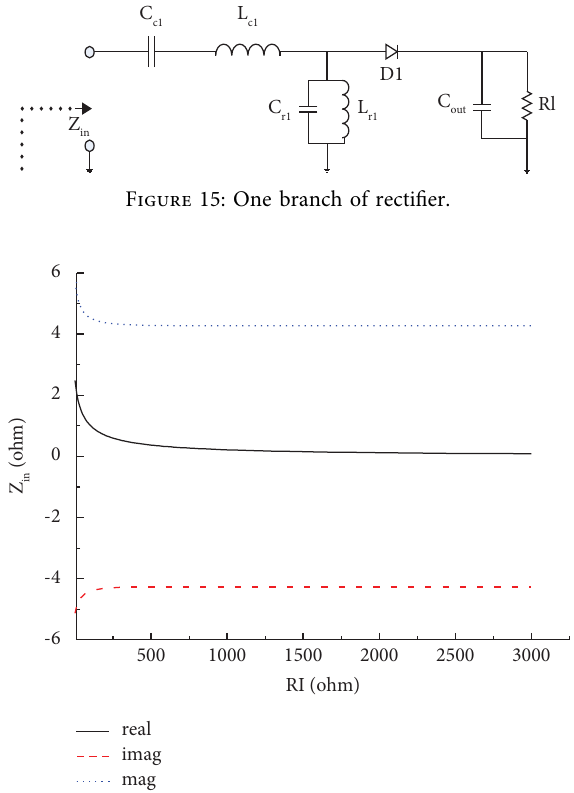
Figure 16: Te input impedance of circuit with one branch of rectifer shown in Figure 15.